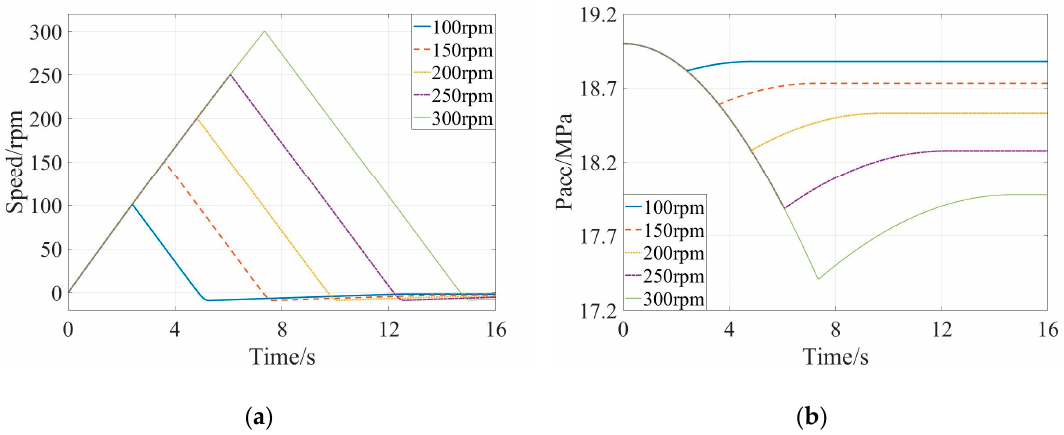
Figure 7. Simulation results with different initial braking speed: ( a ) Evolution of speed of the flywheel, ( b ) Evolution of pressure of the accumulator. Table 5. The simulation results in the operating mode with different initial braking speed.